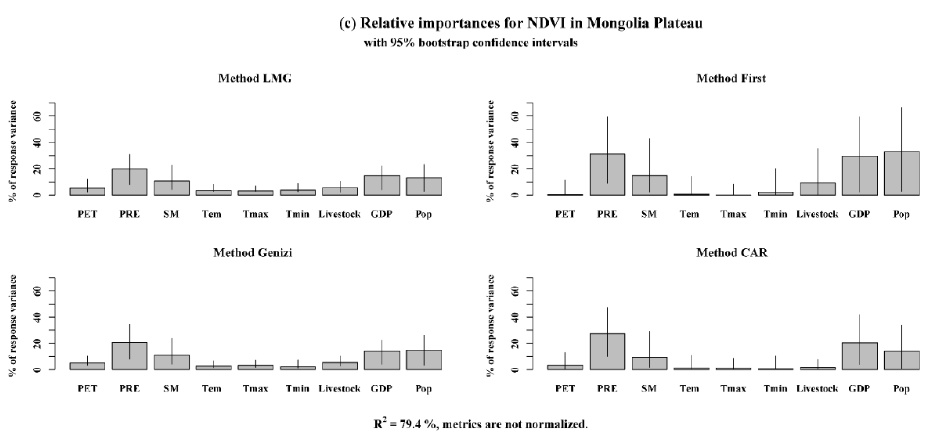
Figure 11. Relative importance of climatic and anthropogenic factors for the mean growing season NDVI in the Mongolia( a ), Inner Mongolia( b ), and whole Mongolian Plateau( c